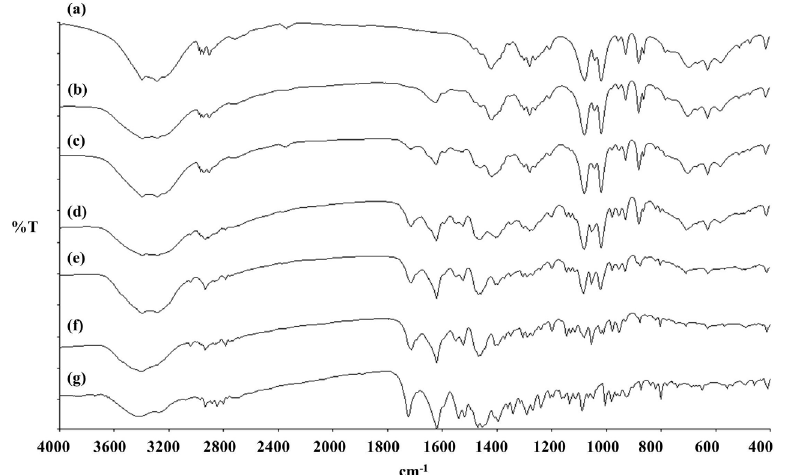
Figure 4. Fourier Transform Infrared Spectroscopy (FT-IR) spectra of ( a ) porous mannitol; ( b – f ) LEV-proliposome formulation No. 1 to No. 5; ( g )